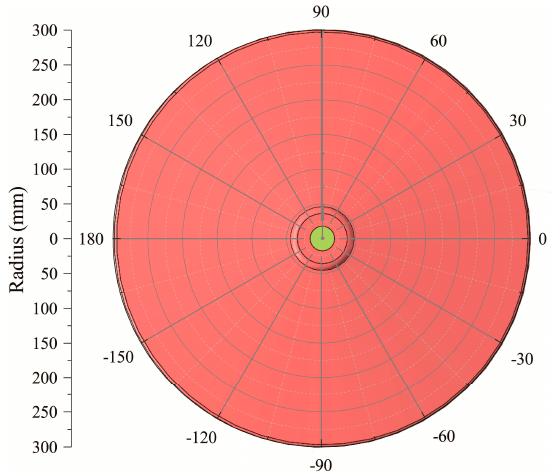
Figure 5. The polar coordinate system on insulator sheds.